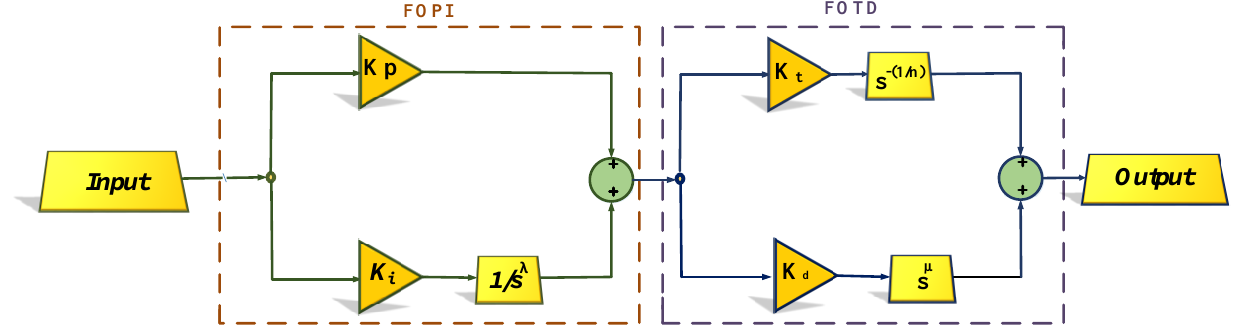
Figure 4 illustrates the block diagram of the proposed FOPI and TD µ cascade controller.